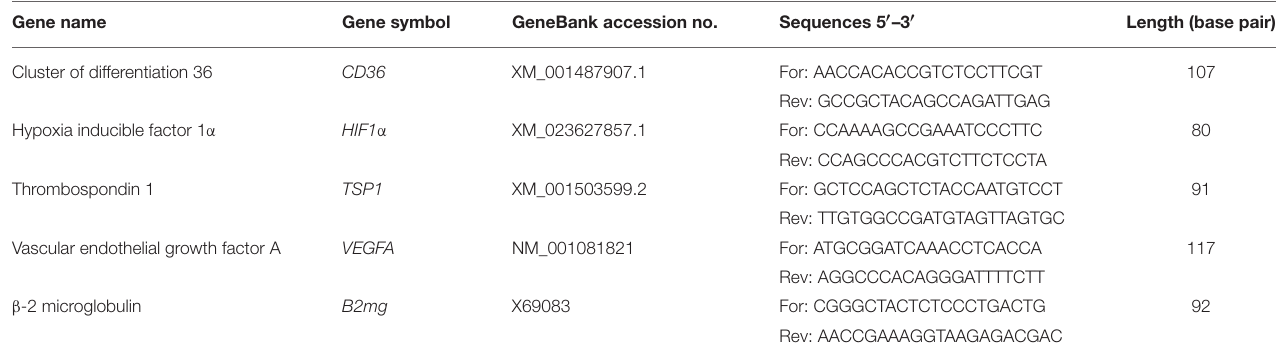
TABLE 1 | Specific primers sequences used for quantitative real-time